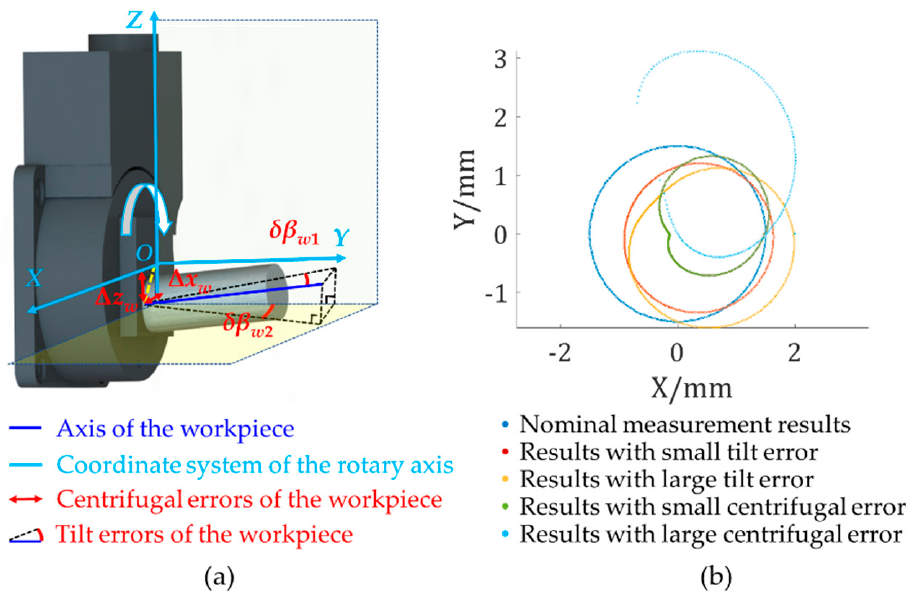
Figure 4. Error identification and simulation: ( a ) a schematic diagram for clamping errors of work- pieces; ( b ) simulation results on clamping errors.